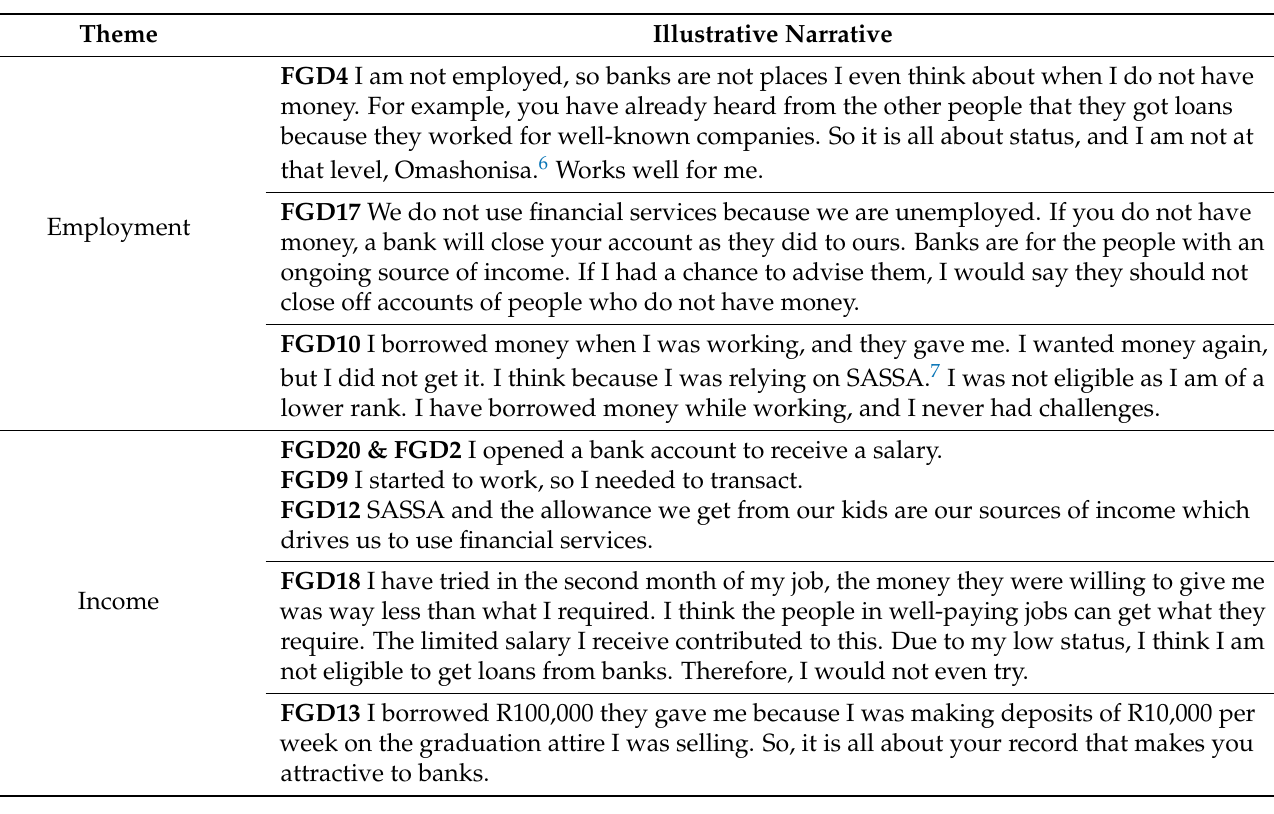
Table 5. Demand-side factors: codes and illustrative